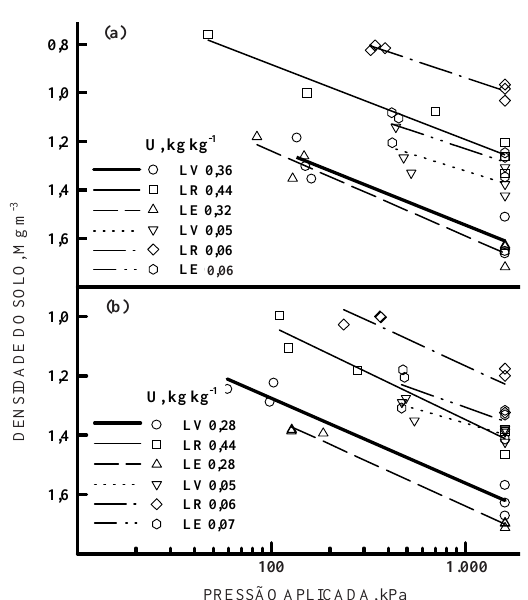
Figura 4. Retas de compressão virgem ajustadas para Latossolo Vermelho-Amarelo (LV), Latossolo Roxo (LR) e Latossolo Vermelho- Escuro (LE) sob mata natural, nas profundi- dades de 0-0,03 (a) e 0,27-0,30 m (b), com a maior e a menor umidade gravimétrica (U) utilizadas (n = 6).